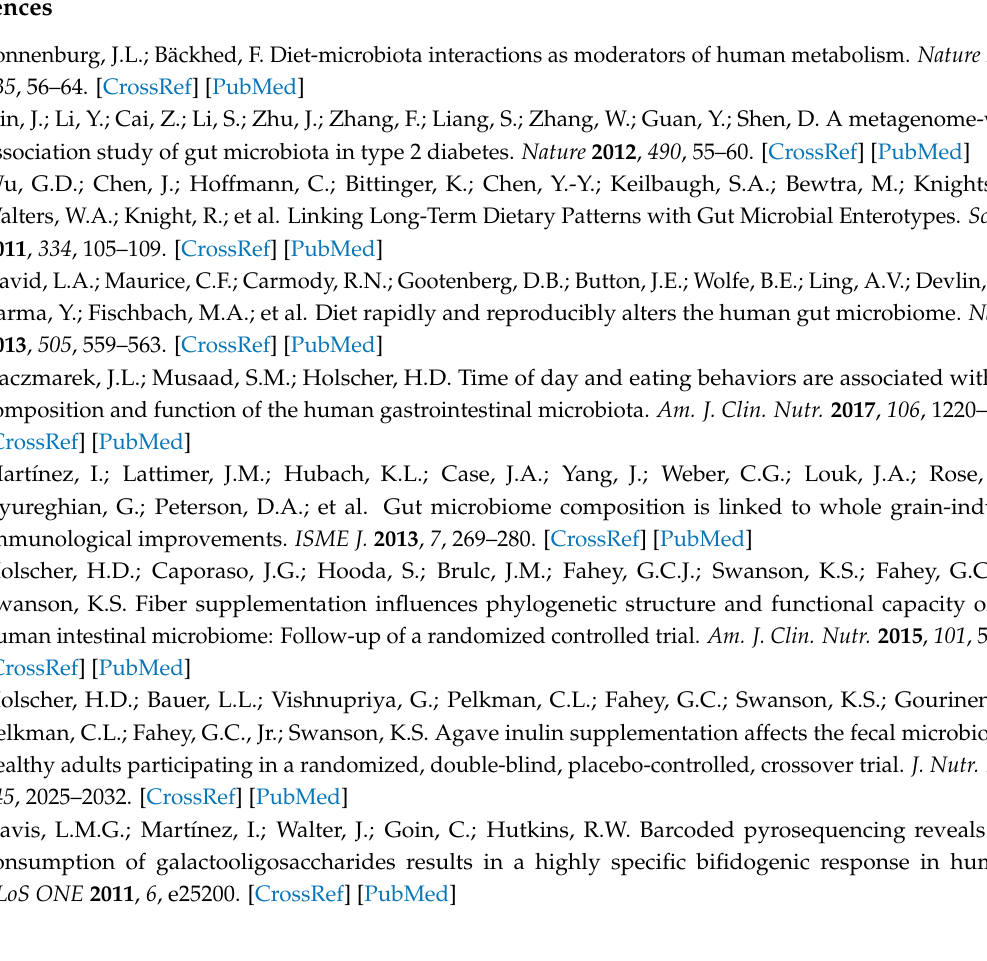
Supplemental Figure S1: Phylogenetic Diversity, Supplemental Figure S2: Observed OTUs, Supplemental Figure S3: Unweighted Unifrac PCoA, Supplemental Figure S4: Weighted Unifrac